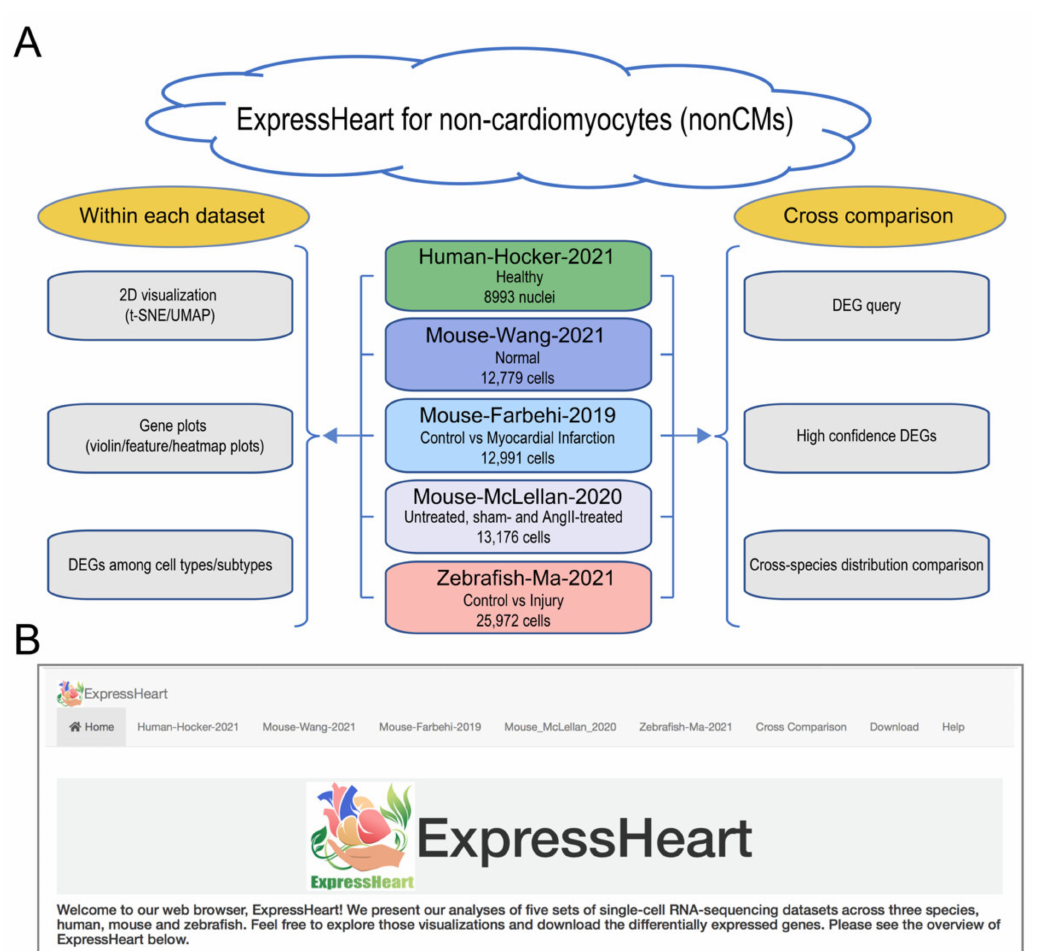
Figure 1. Overview of ExpressHeart. ( A ) Framework and ( B ) interface of ExpressHeart. ExpressHeart contains five scRNA-seq or snRNA-seq datasets (middle of panel A). These datasets are named by the last name of the first author, species, and the year of the corresponding publication or data release. The conditions and numbers of cells/nuclei are also presented in each dataset. On the left of panel A, we show three types of visualization and/or analysis within each dataset, including 2D visualization, gene plots via violin/feature/heatmap, and DEGs among cell types/subtypes. On the right of panel A, we show three types of visualization and/or analyses across different datasets. We provide a module (“Cross-comparison”) for DEG query across all datasets, where we report high confidence DEGs across multiple datasets within the same species for major cell types and compare homolog gene distribution across different species. Panel B shows the interface of the web portal. Each dataset has its own analysis and visualization module, using the same names specified in panel A. “Cross-comparison” module corresponds to three sub-modules showed in the right of panel